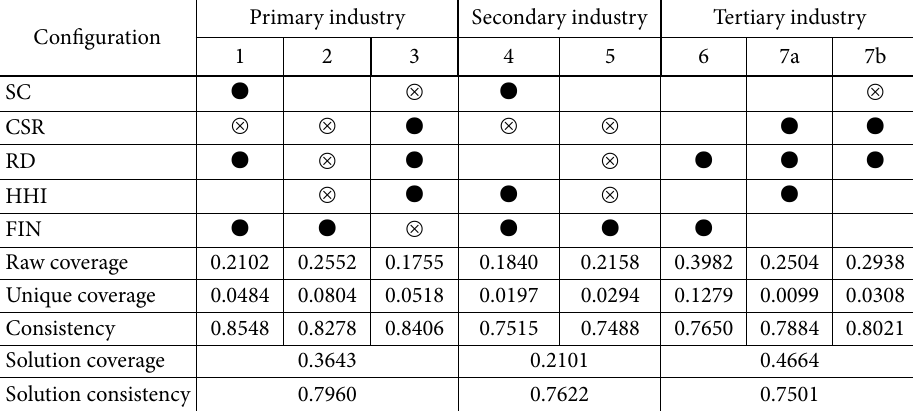
Table 8. Configurations leading to high-level risk-taking of primary industry, secondary industry, and tertiary industry corporates